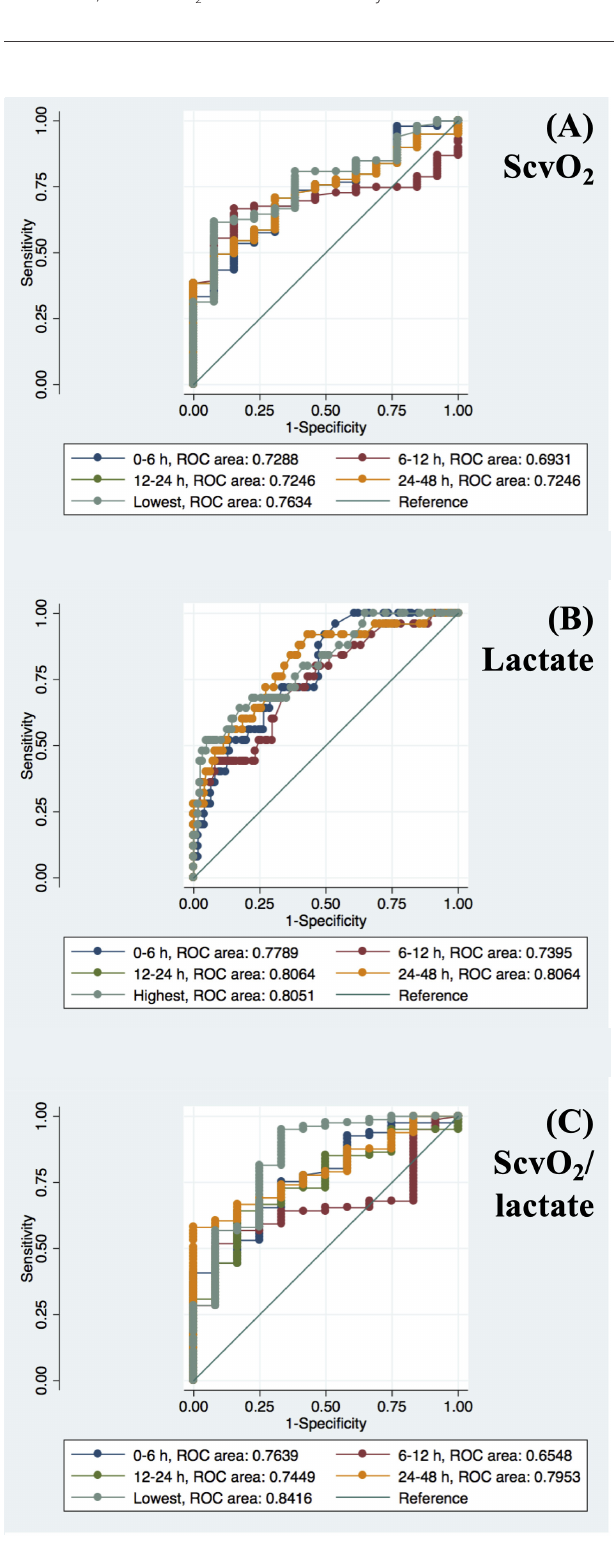
Fig. 2 – Receiver operating characteristics (ROC) curves with respective areas under the ROC curve of (A) central venous oxygen saturation (ScvO ), (B) arterial lactate, and (C) ScvO /lactate ratio in 2 2 children within the first 48 hours after congenital heart surgery for prediction of a major adverse